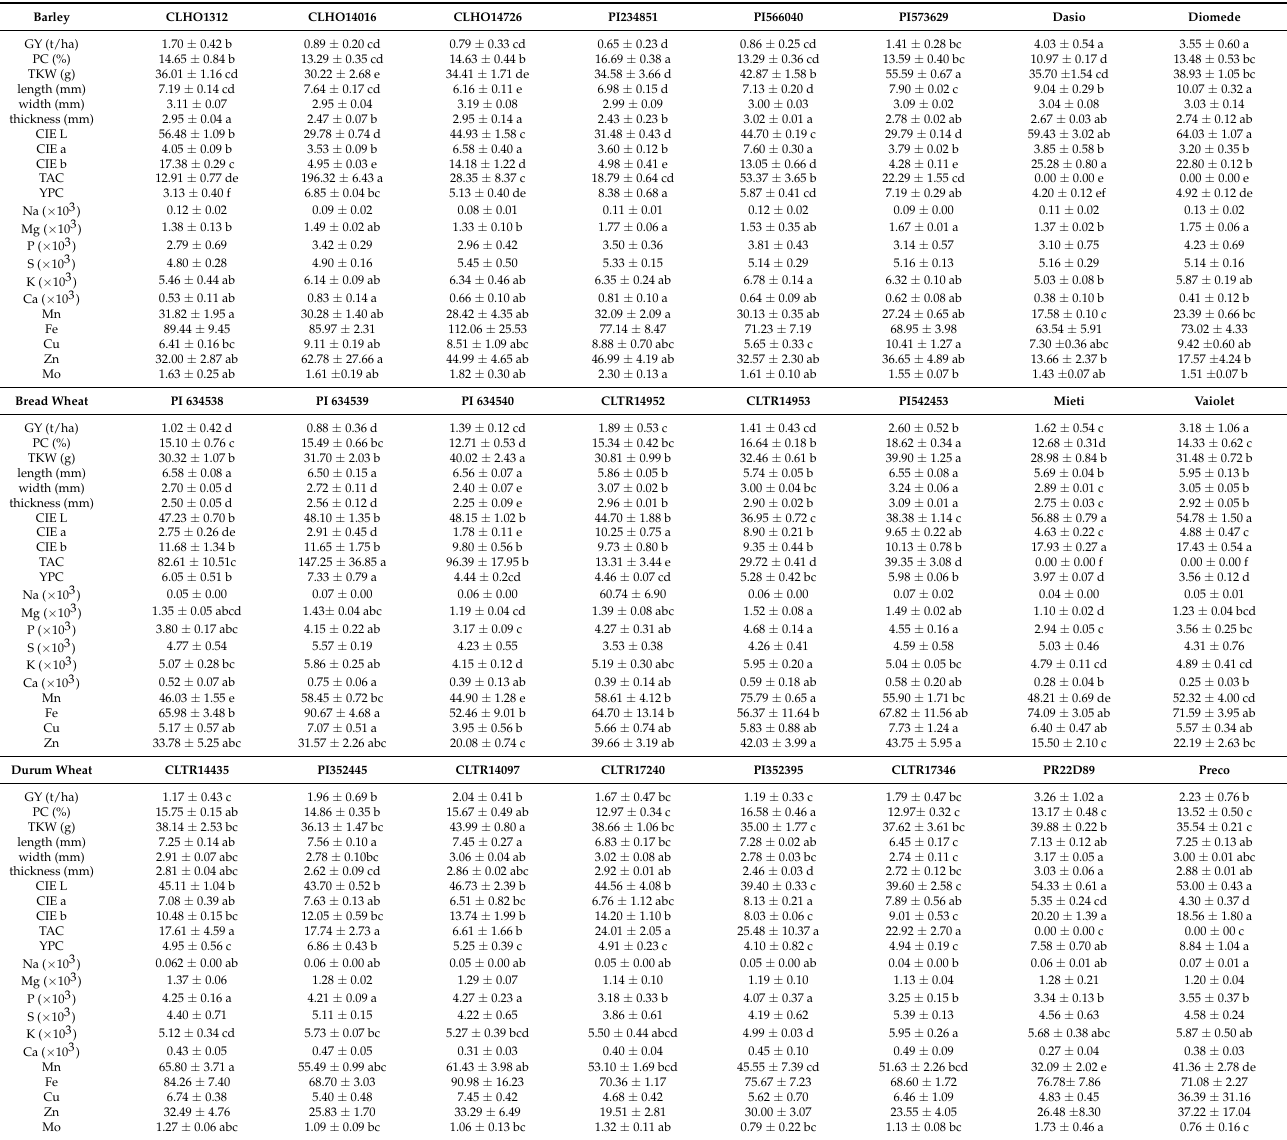
Table 3. Mean value ± SE of each variable investigated in the genotypes of the three species